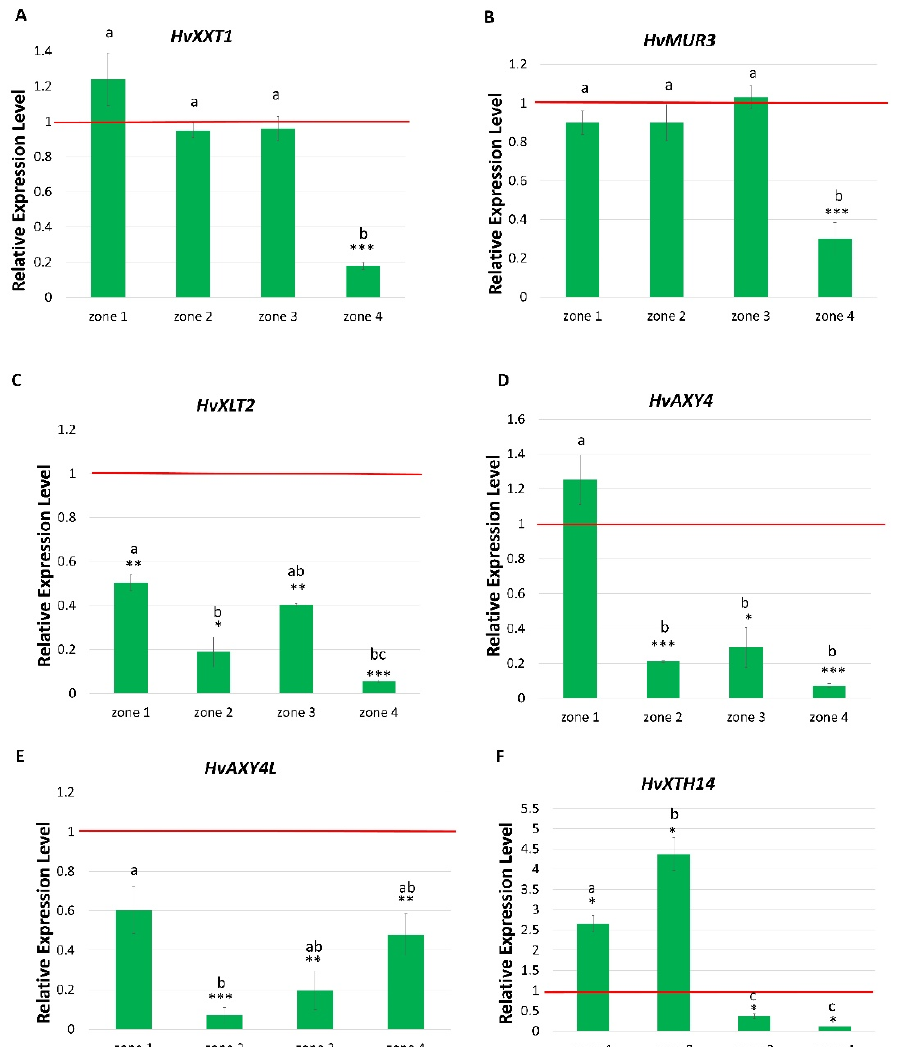
Figure 8. Expression profile of genes potentially involved in XyG synthesis in barley within four root zones of rhp1.e mutant. Relative expression level of each gene was normalized to the expression in the corresponding zones of the WT, which was considered as the value 1 (red line). ( A ) HvXXT1 , ( B ) HvMUR3 , ( C ) HvXLT2 , ( D ) HvAXY4 , ( E ) HvAXY4L , ( F ) HvXTH14 . Root zones: 1—meristematic, 2—elongation, 3—differentiation and 4—developed root hair zone. Different lowercase letters indicate the significant differences between analyzed root zones in mutant according to the one way ANOVA, Tukey’s HSD test ( p < 0.05). Asterisks indicate the significant differences between the mutant and parent variety according to the Student’s t -test (*** p < 0.001; ** p < 0.01; * p < 0.05). Graph shows mean values of n = 3 with